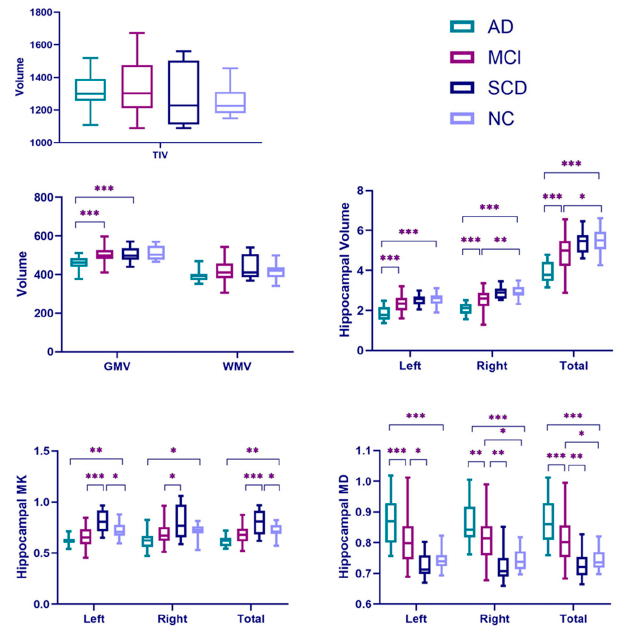
Figure 4. Boxplots of brain volume, hippocampal volume, MD, and MK. Total Hippocampal volume = left hippocampus volume + right hippocampus volume; total hippocampal MD = (left hippocampus MD + right hippocampus MD)/2; total hippocampal MK = (left hippocampus MK + right hippocampus MK)/2. GMV = grey matter volume; WMV = white volume; TIV = total intracranial volume; MK = mean kurtosis; and MD = mean diffusivity. * p ≤ 0.05, ** p ≤ 0.01, *** p ≤